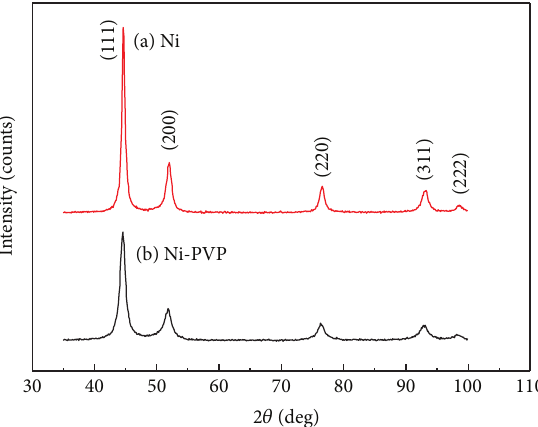
Figure1:XRDpatternof(a)nickeland(b)nickelpowdersstabilized by PVP, precipitated by a chemical reduction method and sonication at temperature 55–65 ∘ C.